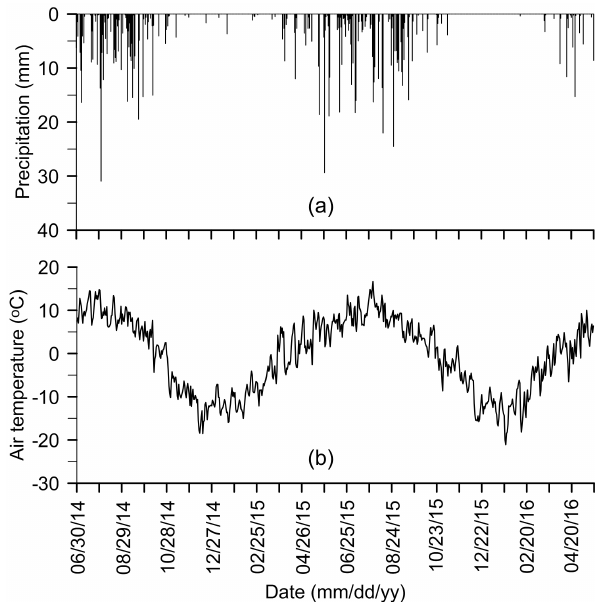
Figure 2. (a) Precipitation and (b) air temperature recorded at an elevation of 3649ma . s . l . within the Hulugou catchment from June 2014 to April